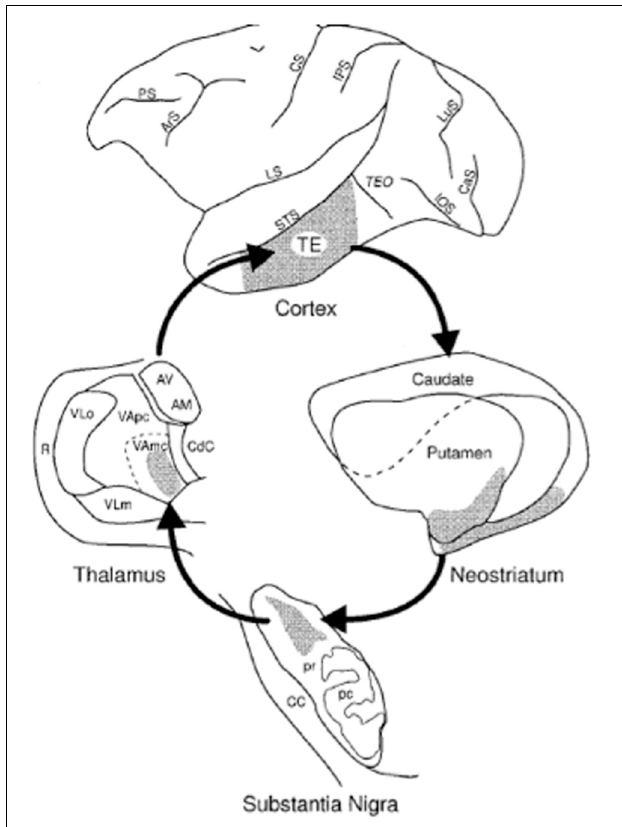
FIGURE 4 | Illustration from Middleton and Strick (1996 Figure 4) showing the closed loop visual corticostriatal connections they found using multisynaptic rabies virus tracing.